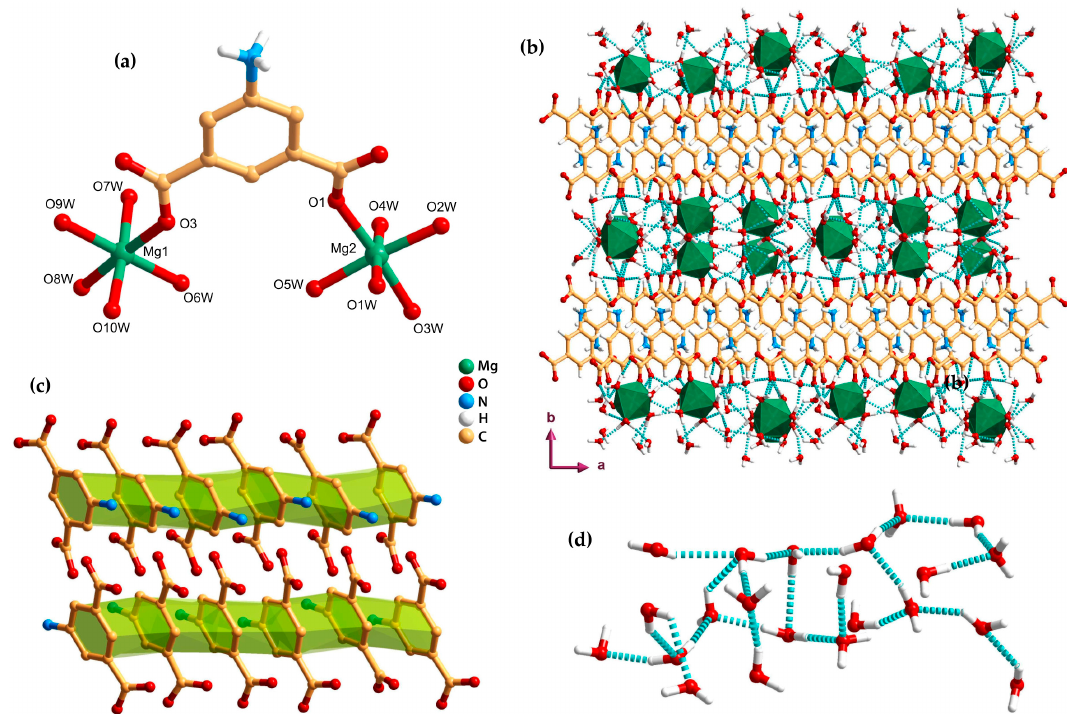
Figure 1. ( a ) The binuclear complex [Mg 2 (Haip)(H 2 O) 10 ] 3 + in the crystal structure of compound 1 , showing the labelling scheme for the two Mg 2 + coordination centers; other selected features of the crystal structure of 1 : ( b ) extended packing viewed in the [1 1 0] direction of the unit cell; ( c ) π ··· π stacking between adjacent organic molecules leading to the formation of supramolecular chains; ( d ) the large (H 2 O)22 cluster (O − H ··· O hydrogen bonds showed as light blue dashed lines). Compound 2 , formulated as [Mg 2 (aip) 2 (phen) 2 (H 2 O) 4 ] 2 · 2(H 2 O), crystallized in a monoclinic unit